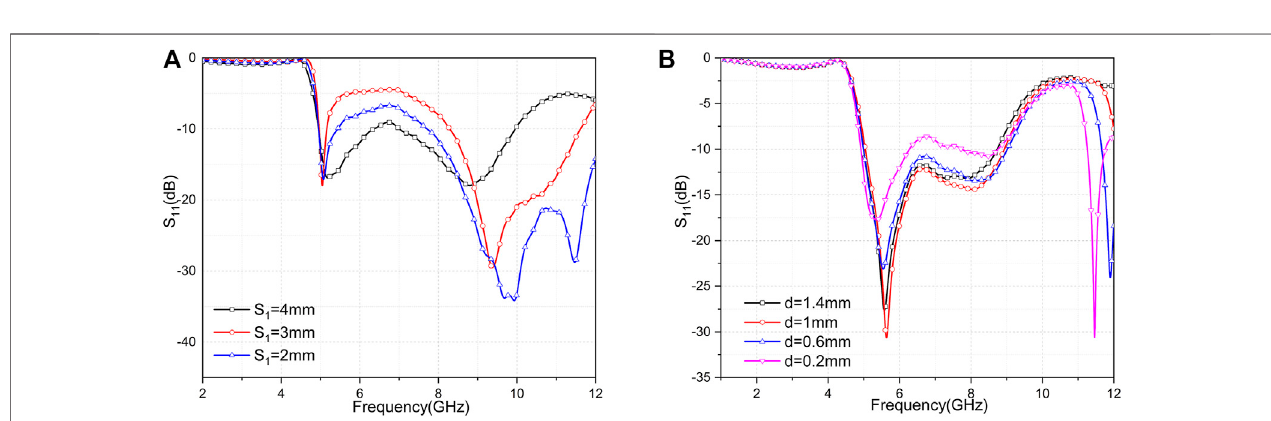
FIGURE 6 | (A) Performing sweep analysis on fi lter parameter S 1 (B) Performing sweep analysis on fi lter parameter d .